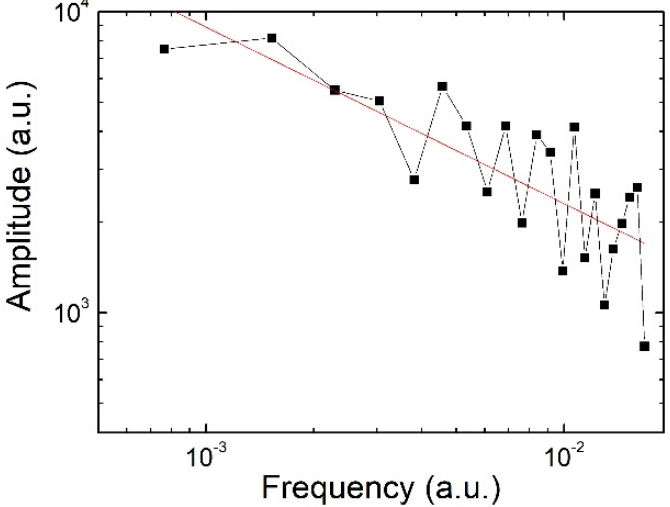
Figure 3. Amplitude of the mantra signal FFT (modified from [8]). Black square denote measure- ments.